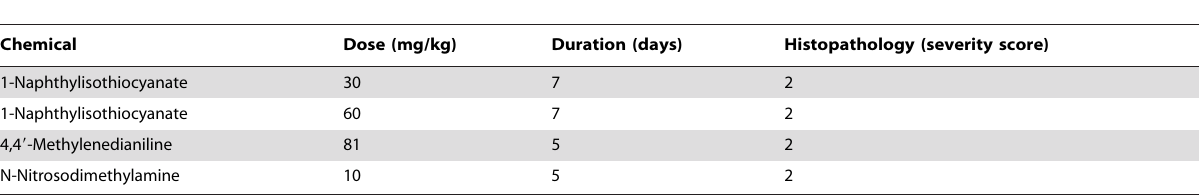
Table 1. Chemical exposure conditions that produced periportal liver fibrosis.